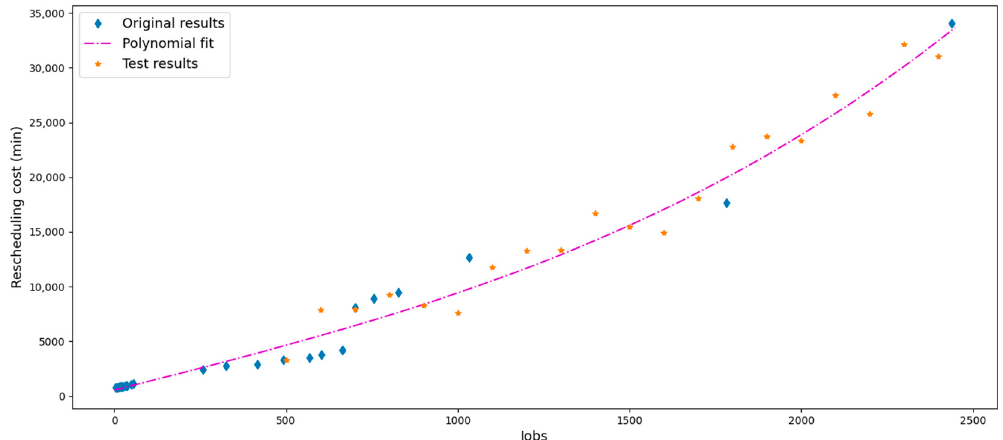
Figure 4. Fitting of experimental results and test results.